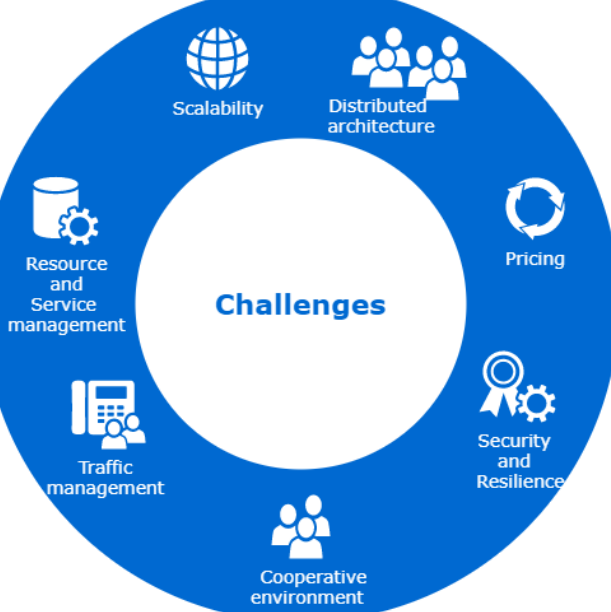
Figure 6. Challenges and